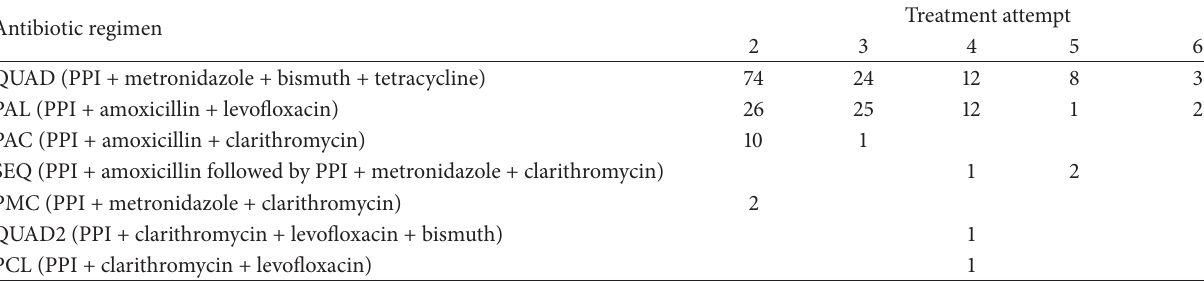
Table 1: Number of salvage treatments for each attempt.